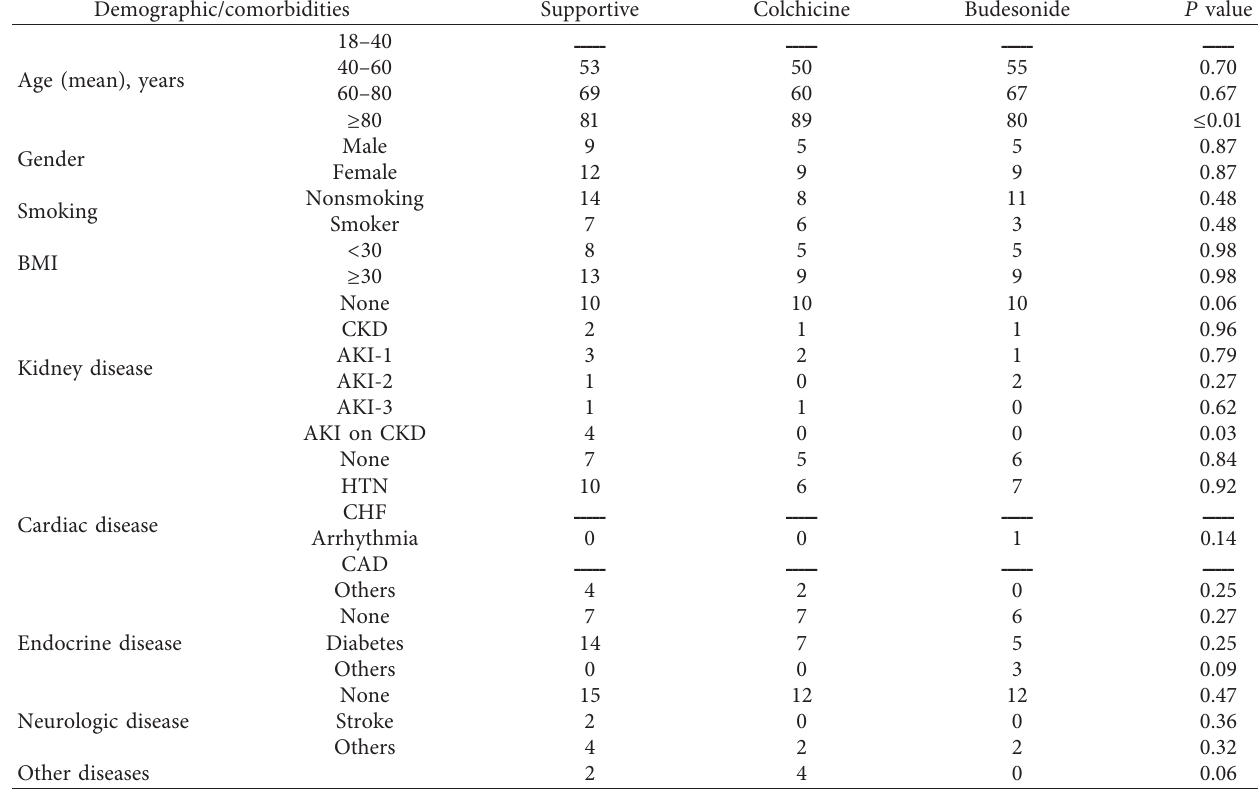
Table 1: Demographics and clinical characteristics.